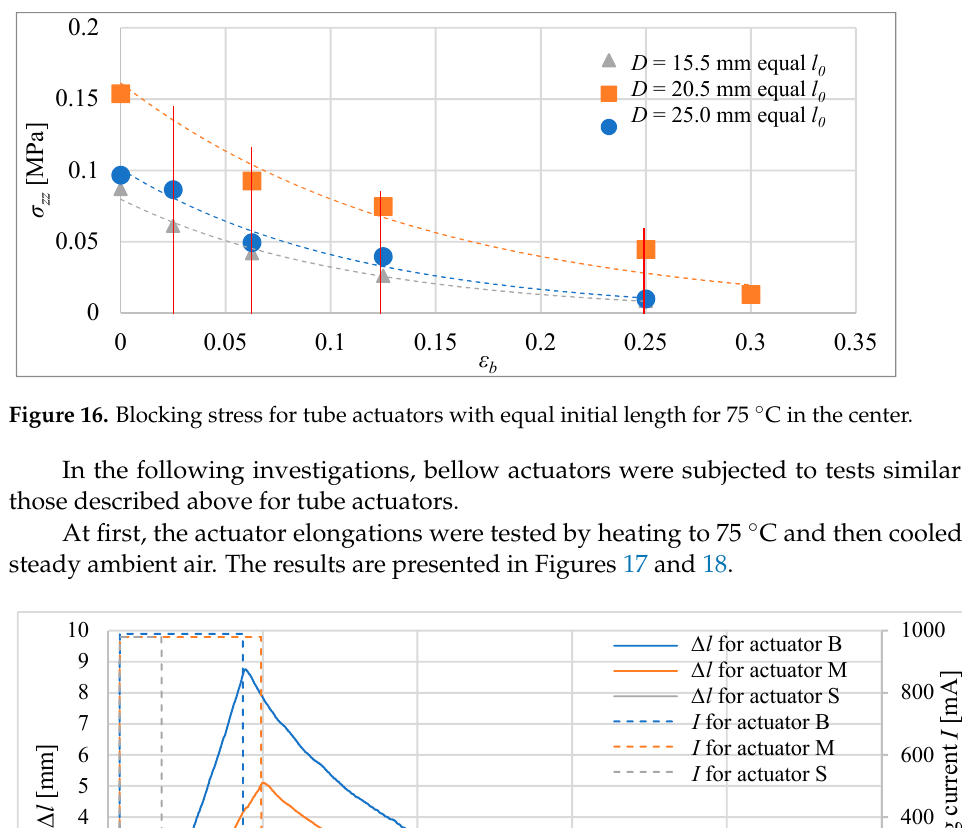
Figure 15. Blocking stress for tube actuators with equal volume for temperature of 75 ◦ C in the center.